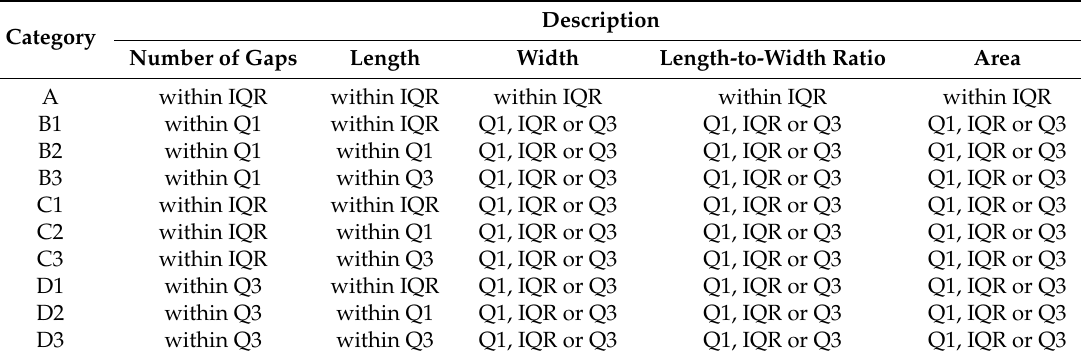
Table 1. Urban corridor